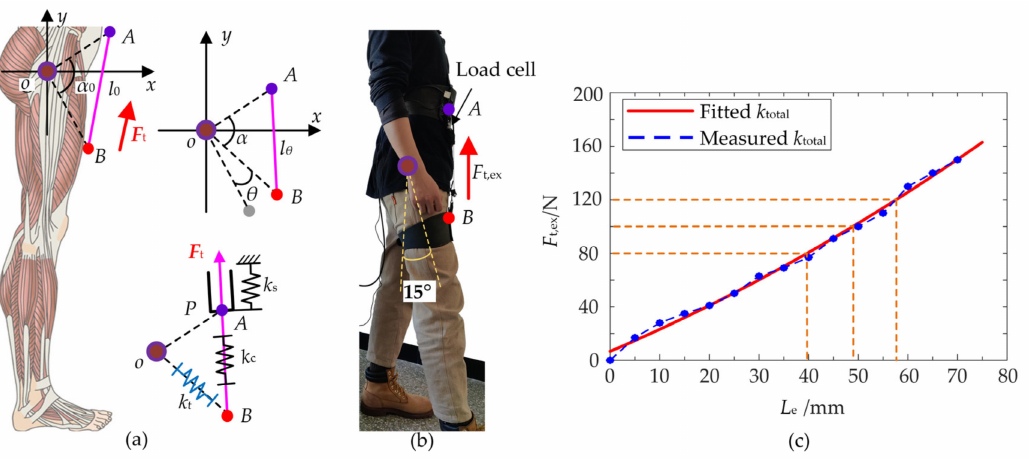
Figure 4. Measurement of the total stiffness. ( a ) The desired displacement consists of the natural displacement of Bowden cables and the elastic deformations of the human–machine system. ( b ) The total stiffness k total was measured when the hip flexed forwards 15 ◦ . ( c ) The external force F t , ex at the equal intervals of displacements are presented and k total can be